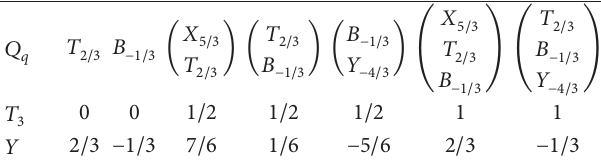
Table 1: Vector-like multiplets allowed to mix with the SM quarks through Yukawa couplings. The electric charge is the sum of the third component of isospin 𝑇 3 and of the hypercharge 𝑌 . Adapted from [9].